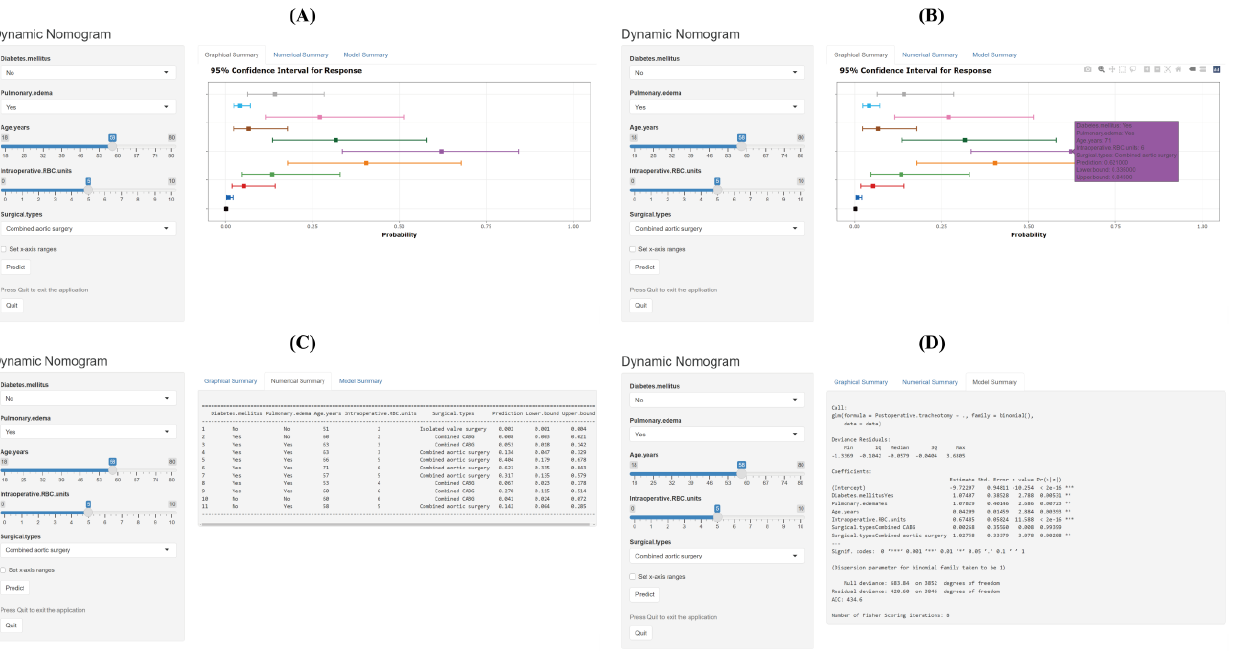
Figure 2. The usage of the internet-based risk calculator for POTs after HVS. ( A ) The estimated probabilities and corresponding 95% CIs of POT of 11 different patients are presented. The squares represent the estimates and the bars reflect their 95% CIs. ( B ) The detailed information of a patient and the corresponding estimated risk with 95% CI will appear when the square is clicked. ( C ) All the information of the patients can be acquired by clicking the “Numerical Summary”. ( D ) The information of the model can be acquired by clicking the “Model Summary”. CI, confidence interval; HVS, heart valve surgery; RBC, red blood cell; POT, postoperative tracheostomy. The lines of each color represent the risk in one case.